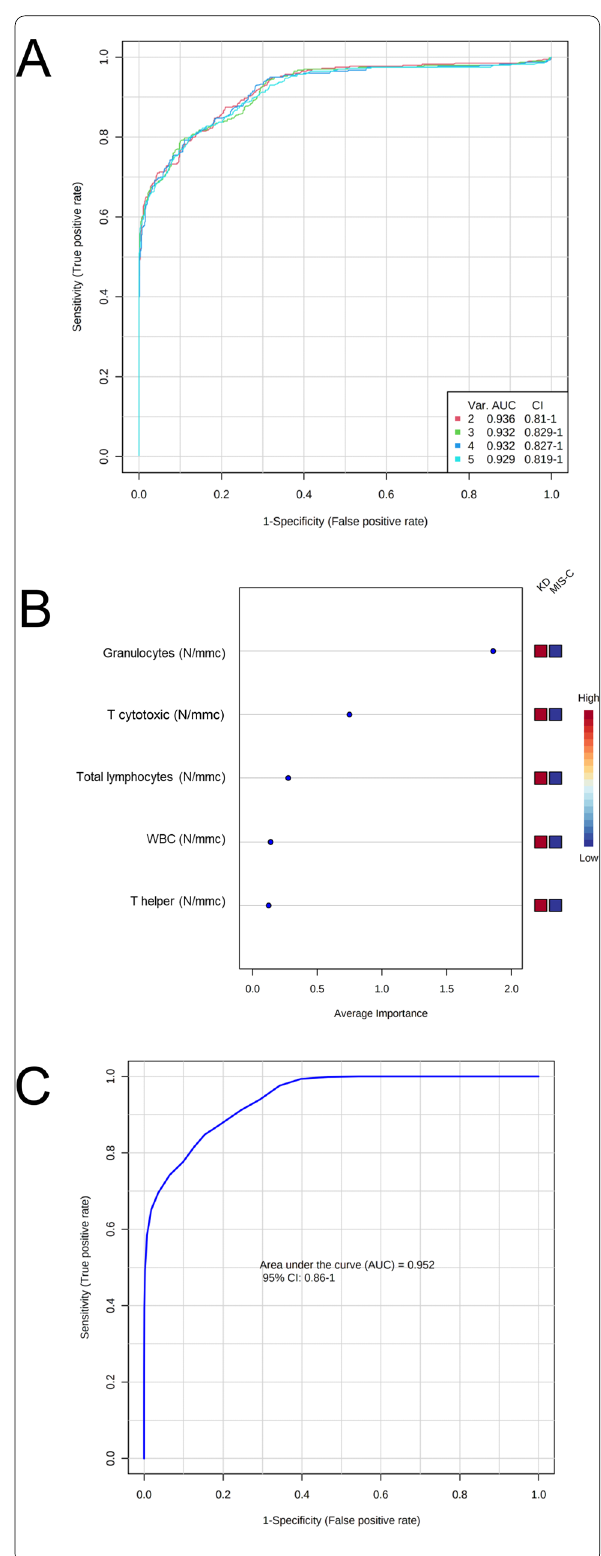
Fig. 3 Multivariate ROC curve analyses. A : comparison of ROC curves to discriminate MIS-C from KD patients using from 2 to 5 variables (Explorer); B : rank features for average importance; C : ROC curve Tester using granulocyte number and T cytotoxic lymphocyte number as features. AUC: area under the ROC curve; KD: Kawasaki disease; MIS-C: multisystem inflammatory syndrome in children; ROC: receiver operating characteristic; WBC: white blood